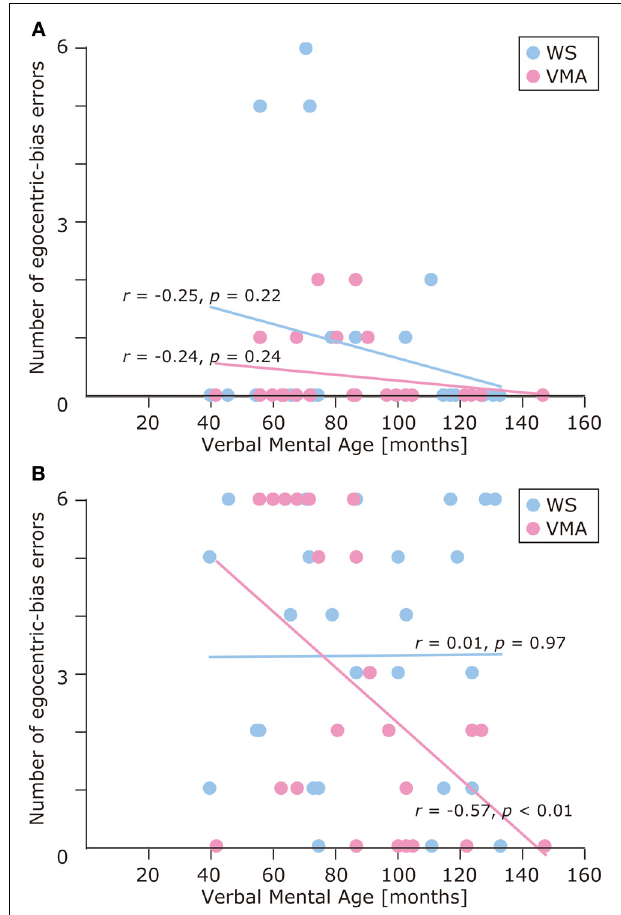
FIGURE 5 | Developmental trajectories for the number of egocentric-bias errors in (A) the MR task, and (B) the VPT2 task for two groups [blue: Williams syndrome (WS) group; pink: verbal mental age-matched (VMA)